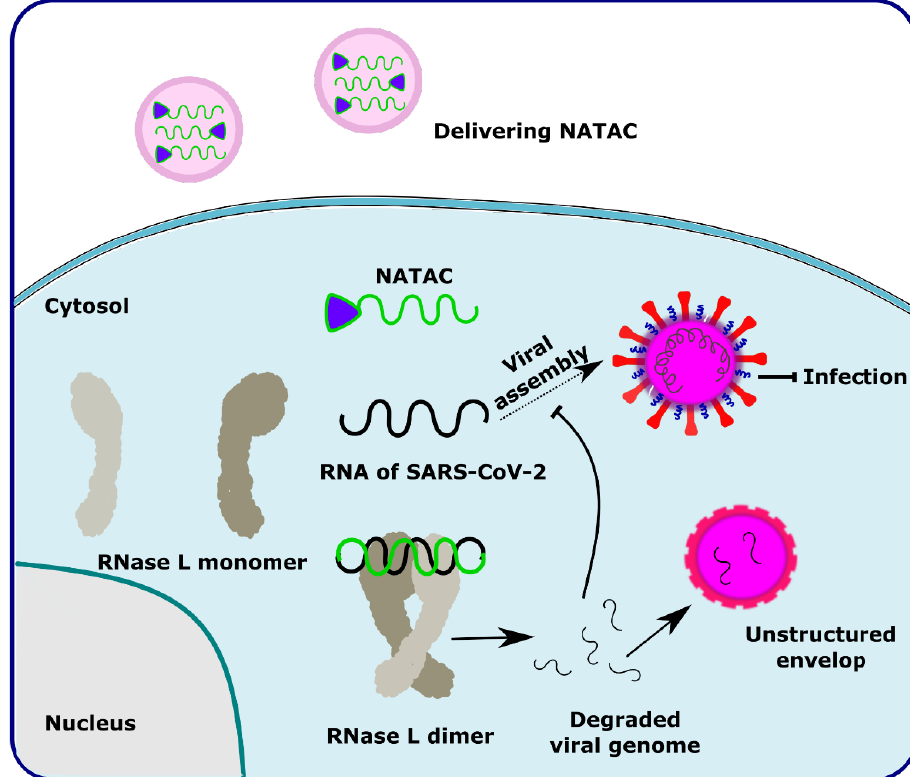
Figure 5. Schematic representation of the mechanism of action of NATAC molecules in targeting the SARS-CoV-2 virus. Adapted from [55].